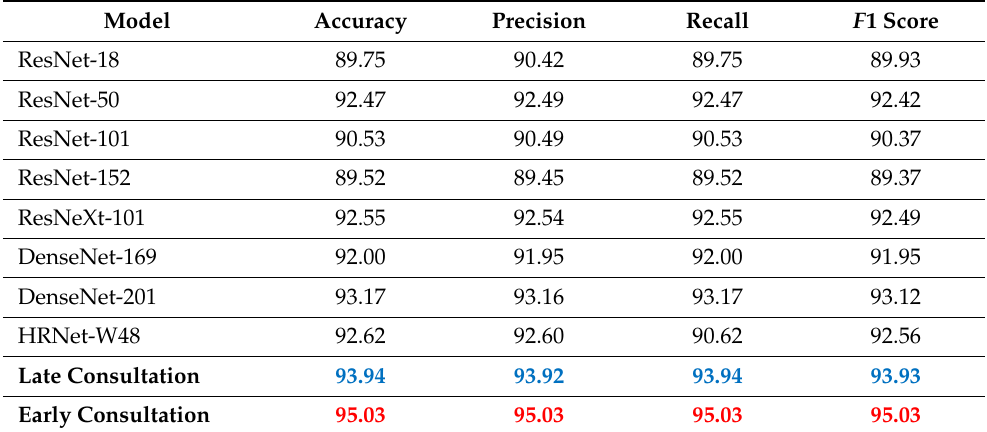
Table 5. Ablation study on the chest X-ray dataset [40]. The performance of individual doctor models and two implementations of doctor consultation-inspired models. The top-two methods are marked in red and blue ,